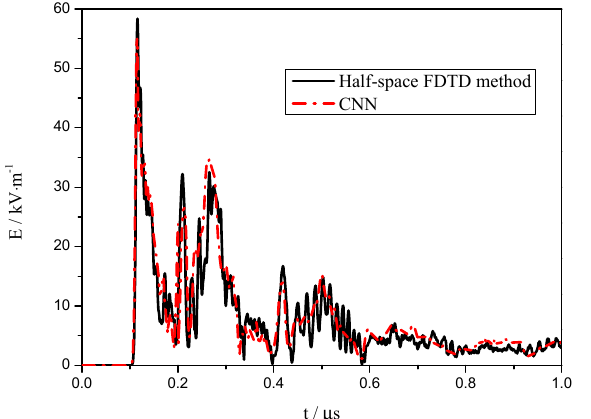
Figure 5. Comparison of electric field predicted by CNN model to half-space FDTD method.